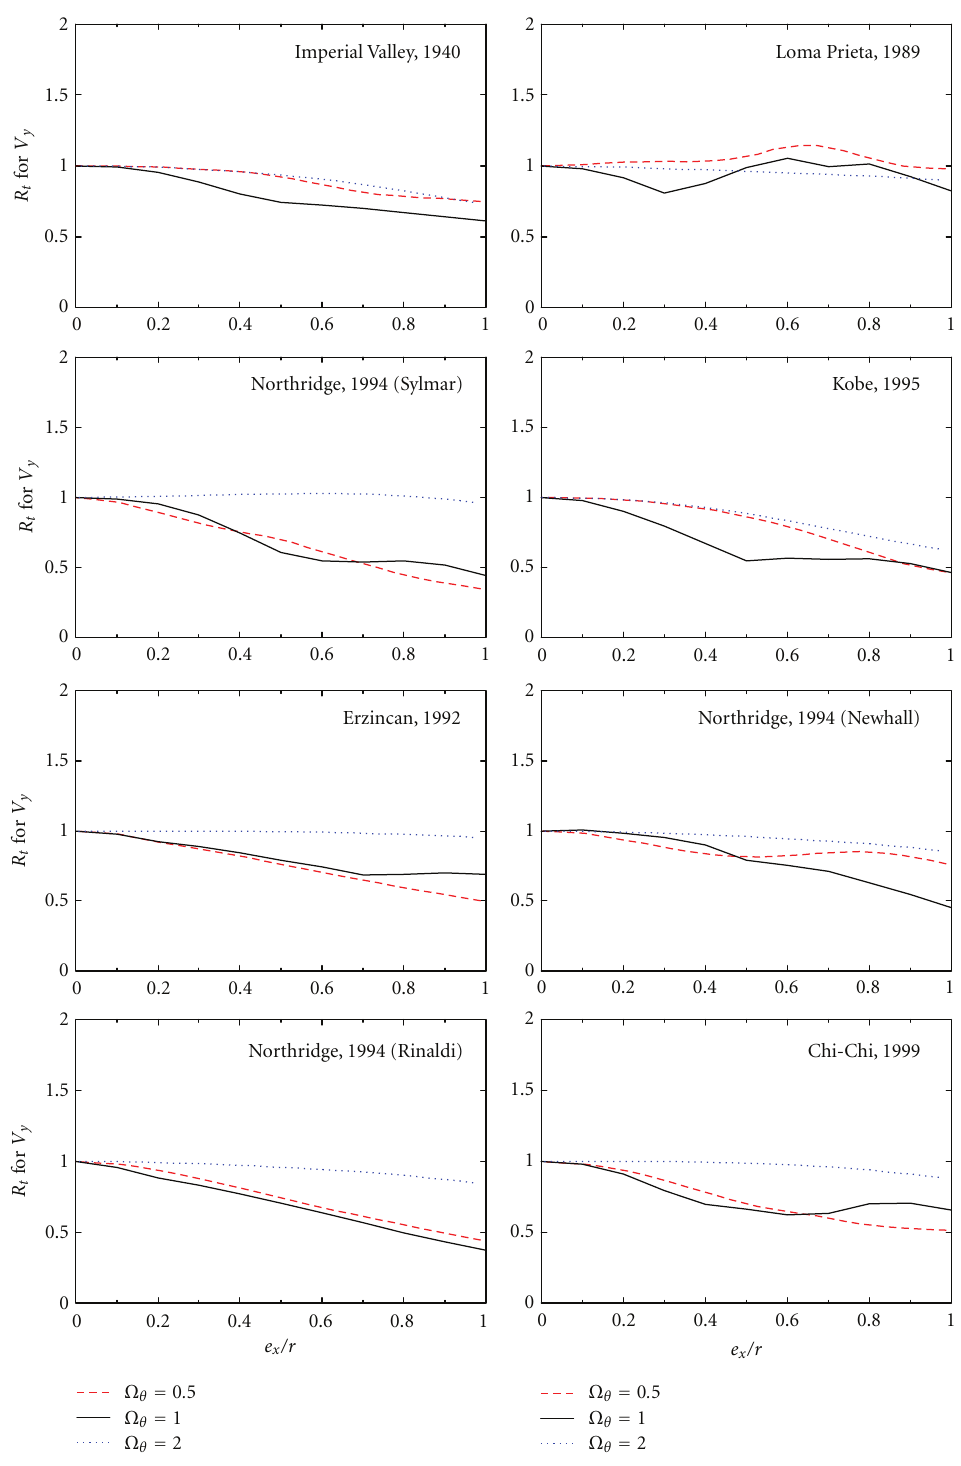
Figure 13: E ff ect of eccentricity on response ratio, R t for peak base shear, V y ( T y =